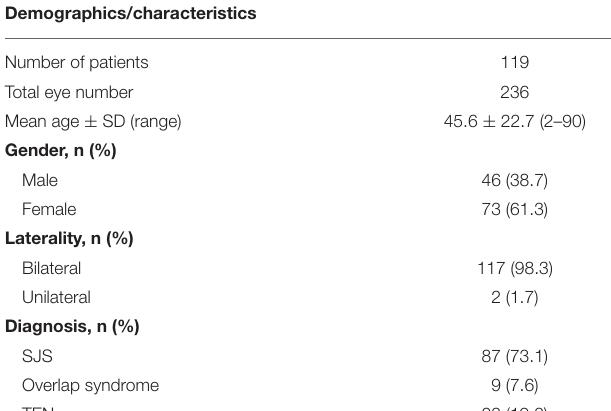
TABLE 1 | Demographics and grading of patients receiving ophthalmic examination in acute and chronic stage of SJS/TEN from 2010 to 2020.